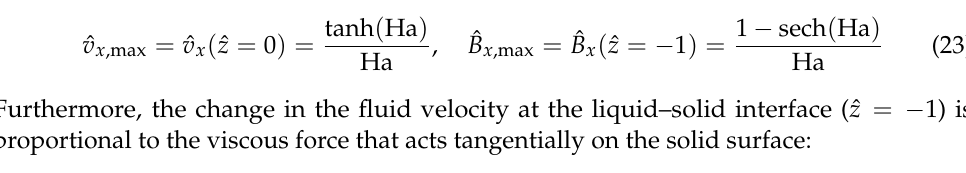
proportional to the viscous force that acts tangentially on the solid surface: